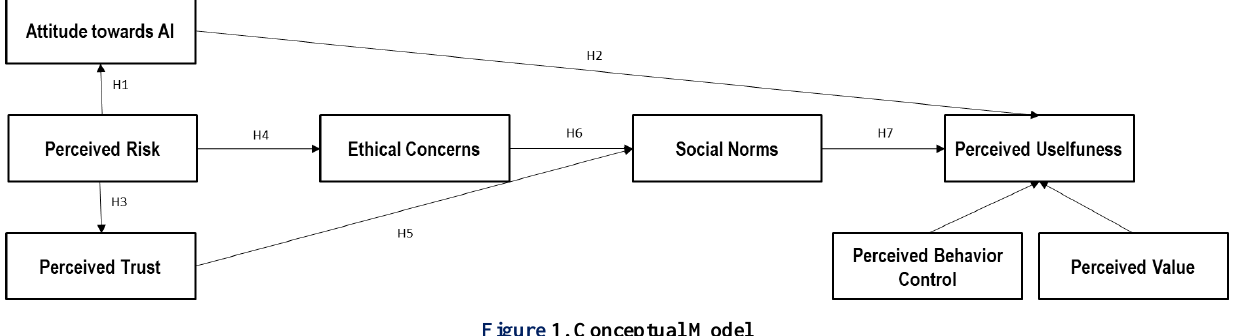
Figure 1. Conceptual